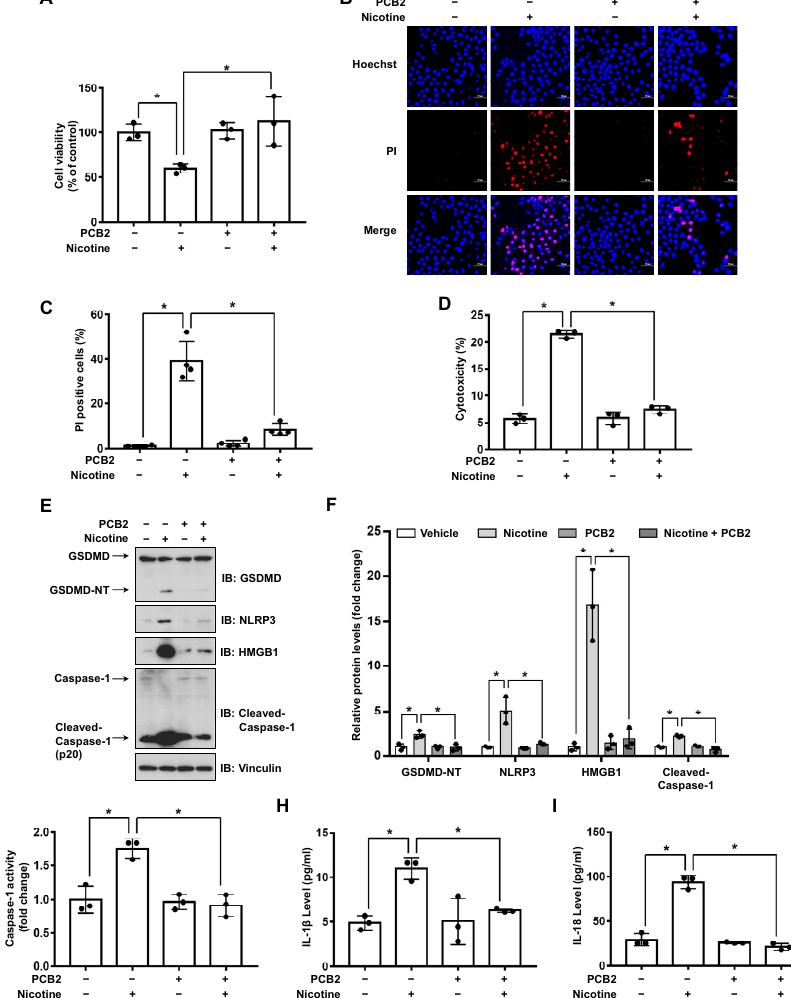
Figure 4. PCB2 prevents nicotine-induced pyroptosis in hepatocytes. LO2 cells were treated with 10 µ M PCB2 for 24 h followed by the incubation with 100 µ M nicotine for 24 h before harvesting. ( A ) Cell viability was detected by CCK-8 assay following exposure to nicotine ( n = 3). ( B , C ) Hoechst 33342/PI staining, fluorescence imaging ( B ) was acquired by confocal microscopy. Scale bar: 50 µ m. The percentage of PI-positive cells ( C ) was analyzed by using ImageJ software ( n = 4). ( D ) Cytotoxicity was determined by LDH release assay following exposure to nicotine ( n = 3). ( E ) The proteins levels of GSDMD, NLRP3, HMGB1 and Cleaved-Caspase-1 by using immunoblotting. ( F ) Quantification of GSDMD-NT, NLRP3, HMGB1 and Cleaved-Caspase-1 levels as in ( E ) ( n = 3). ( G ) The activity of Caspase-1 was determined by using Caspase-1 activity assay kit ( n = 3). ( H , I ) The concen- trations of IL-1 β ( H ) and IL-18 ( I ) in the conditioned medium were determined by ELISA ( n = 3). Data shown represent the mean ± SD (*, p < 0.05).